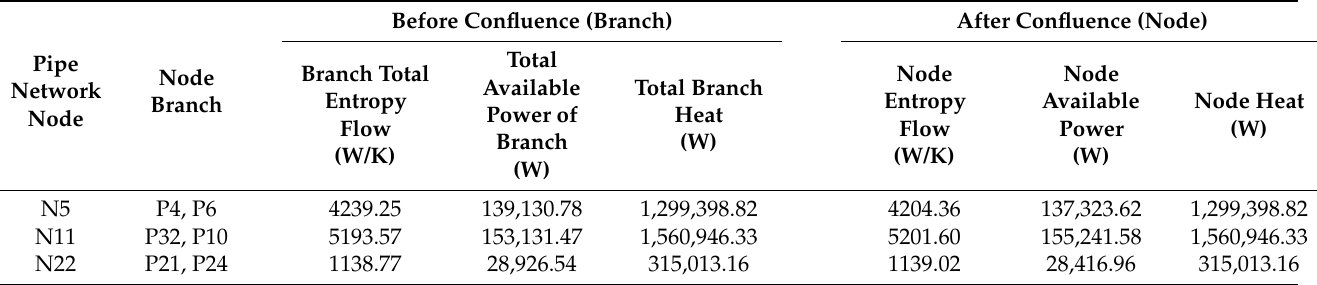
Figure 4. Available thermal power of typical nodes in Case I. Table 2. Related thermodynamic parameters of typical heating network nodes Case